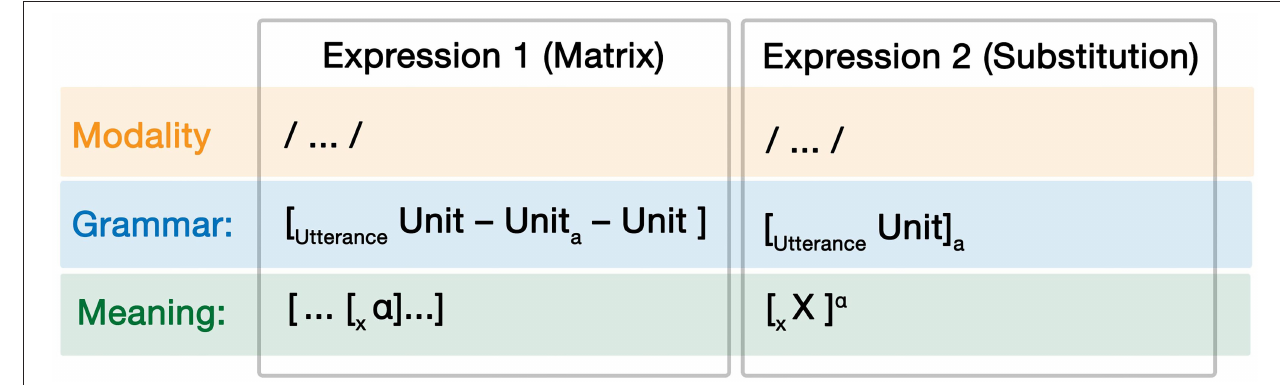
FIGURE 8 | Abstracted correspondence schema for substitutive